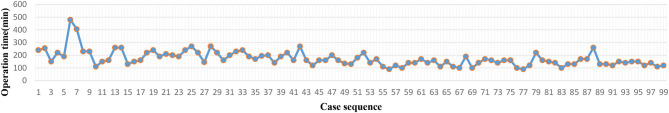
Graph of operative times plotted for each robotic NOSES for Prof. Yao.